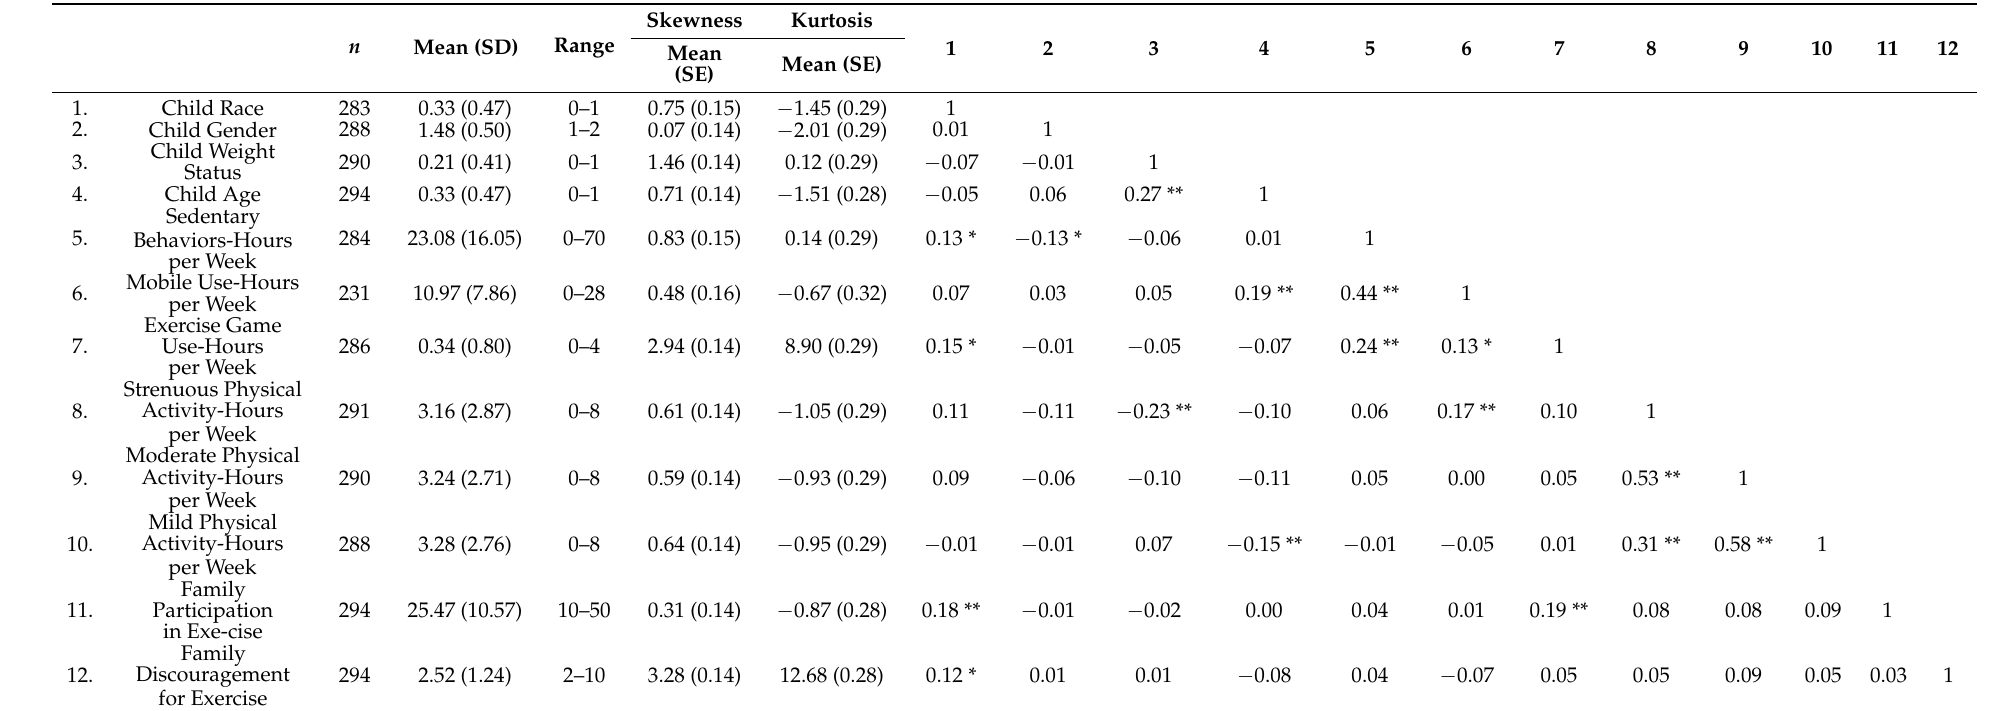
Table 2. Scale Descriptives and Bivariate Correlations for Study